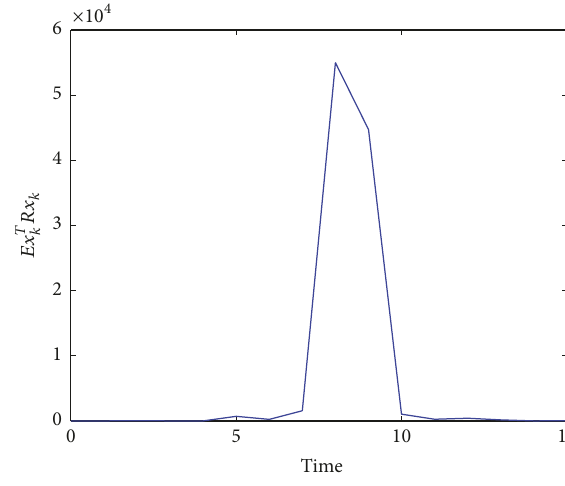
Figure 5: 𝐸(𝑥 T 𝑘 𝑅𝑥 𝑘 ) of the open-loop system for Example 2.